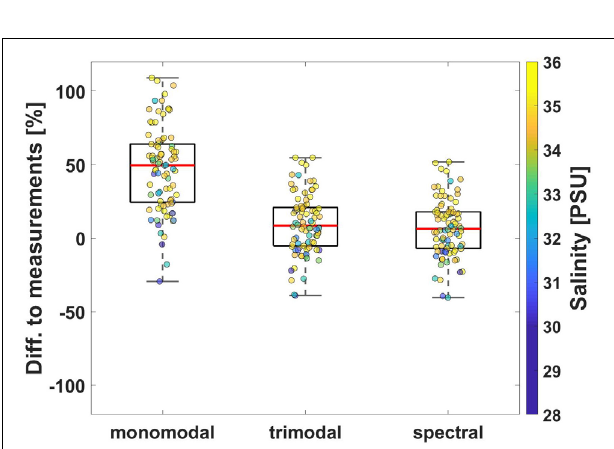
FIGURE 6 | Examples of measured and modeled PAR profiles at selected stations. Overestimation of available PAR by the trimodal approach (left) , match of model and measurements (center) , and underestimation (right) .